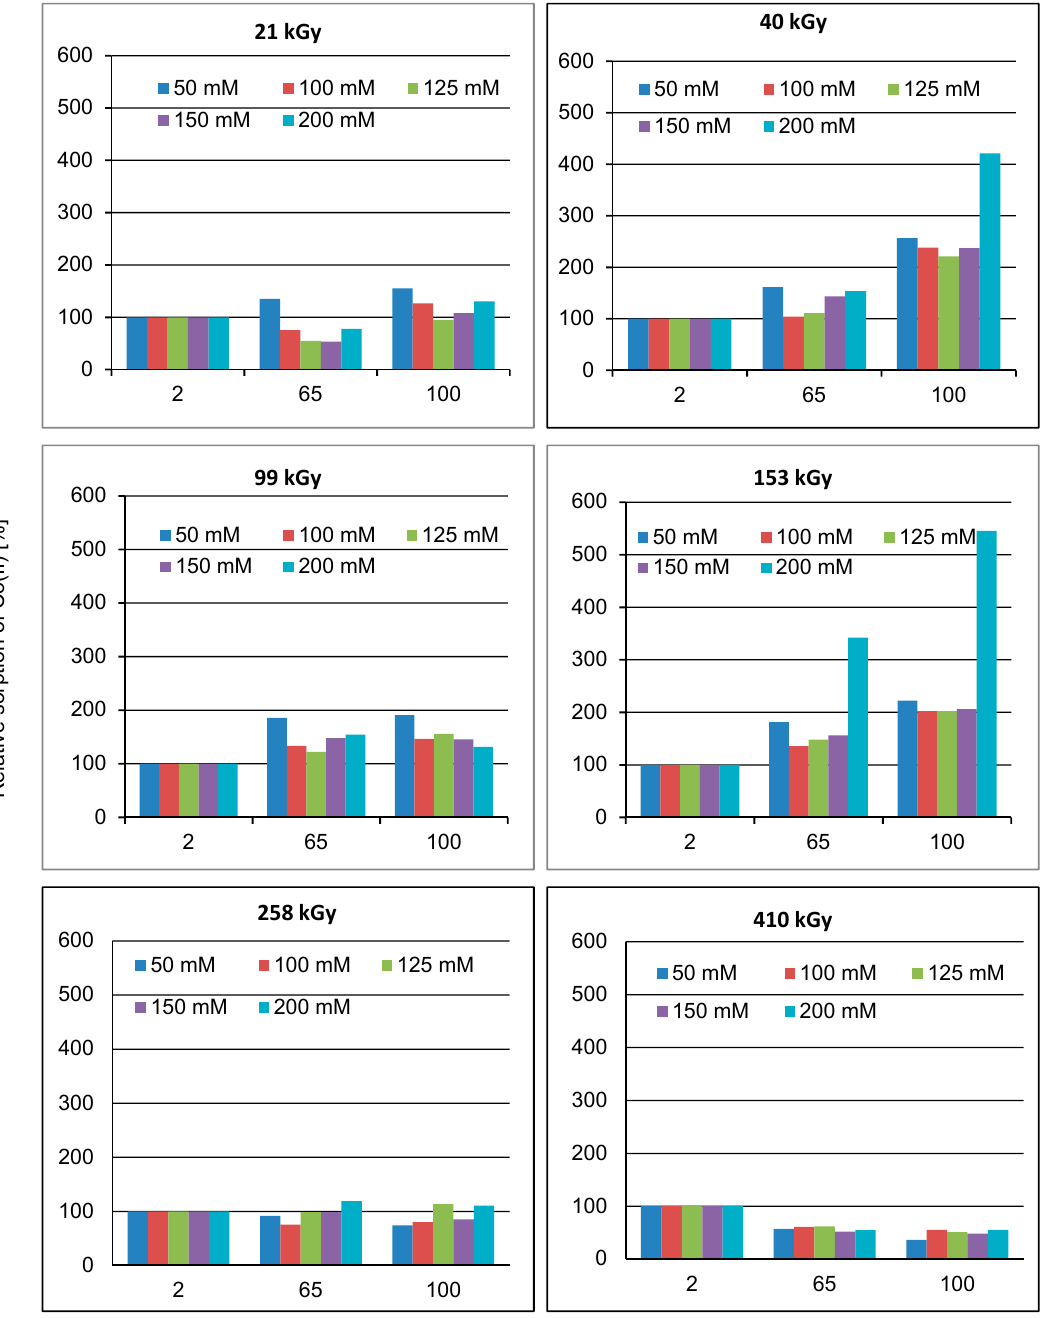
Figure 6. Relative time variation of Co(II) sorption on the wool compared with sorption for 2-day’s lapse from the exposure.